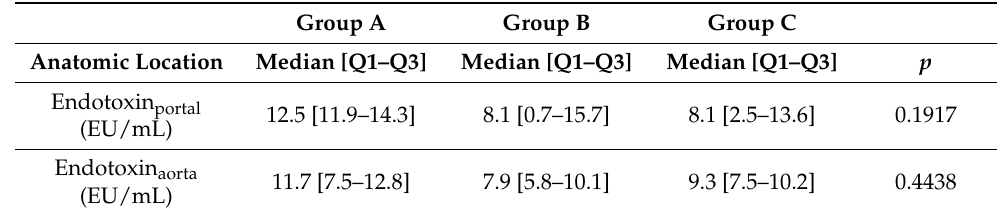
Table 6. Endotoxin levels at the studied locations for the three study groups. Blood samples from portal vein and the aorta.